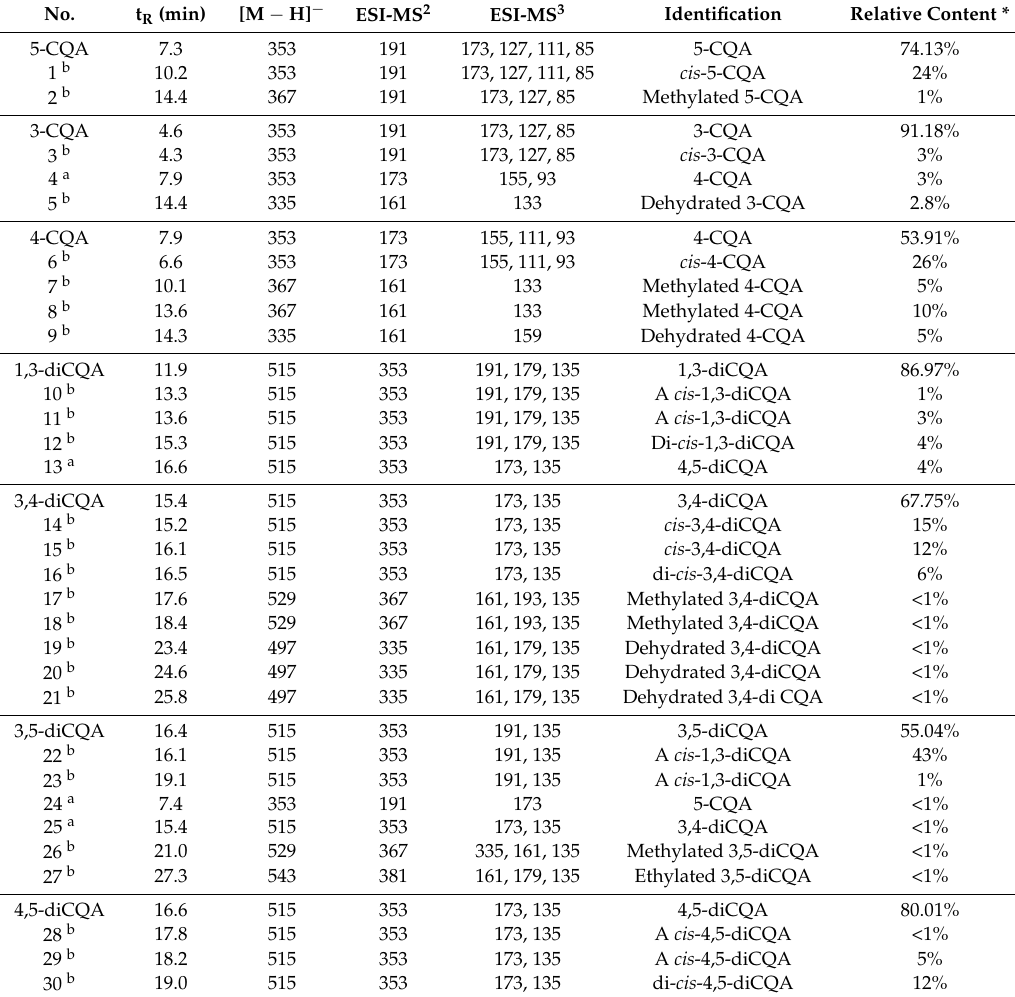
Table 3. Characterization of degradation products of CQAs determined by HPLC-CID-ESI-MS/MS.